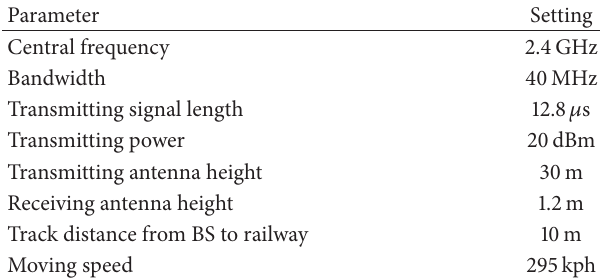
Table 1: Configurations of the measurement campaign.